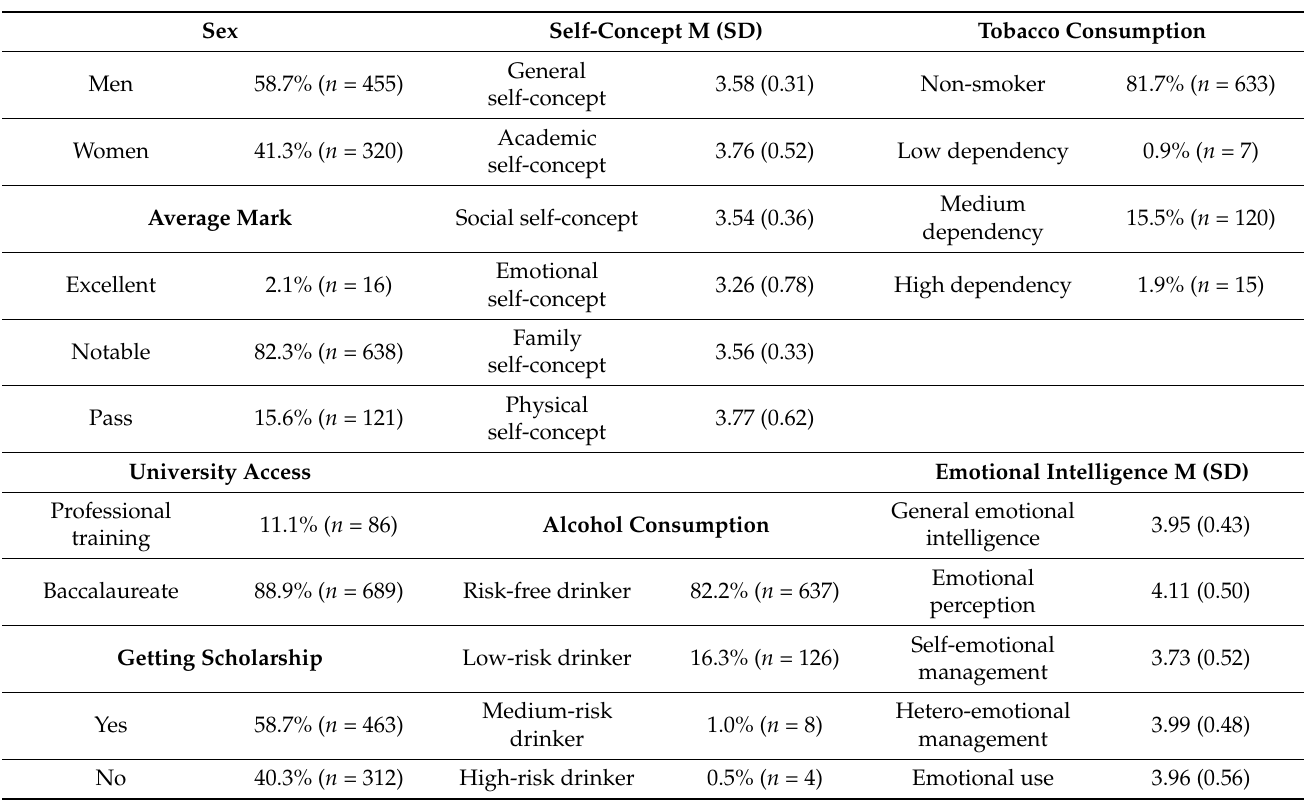
Table 1. Descriptive